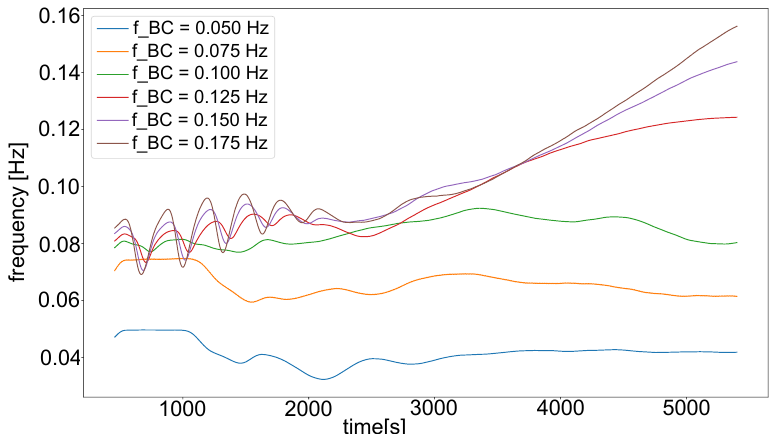
Figure 16. Comparison of provided service frequencies over time for different frequencies of transac- tion confirmation.